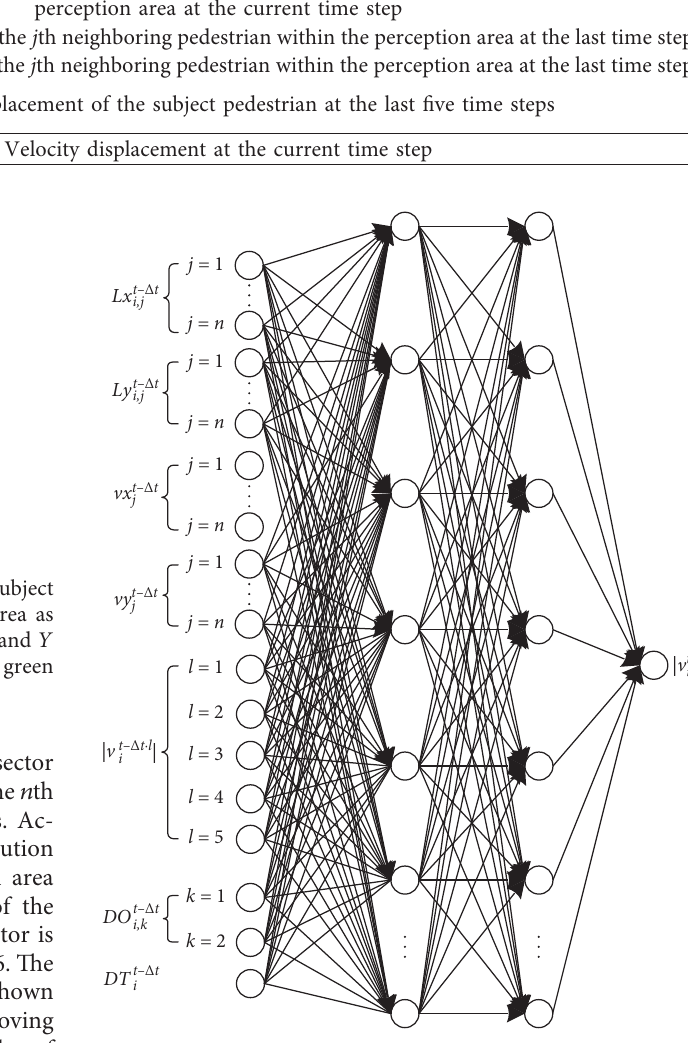
Figure 3: Architecture of the neural network in the velocity dis- placement submodel